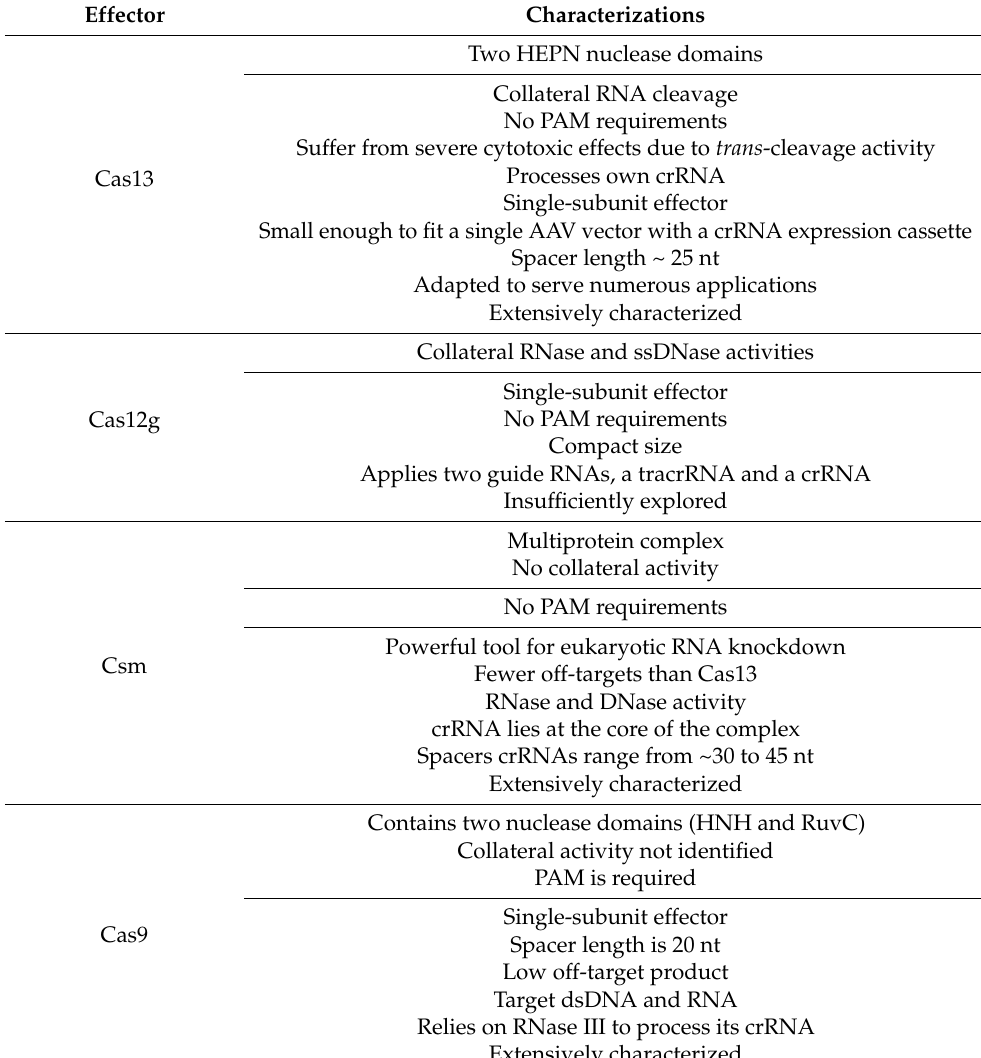
Table 1. Main characteristics of RNA-targeting CRISPR